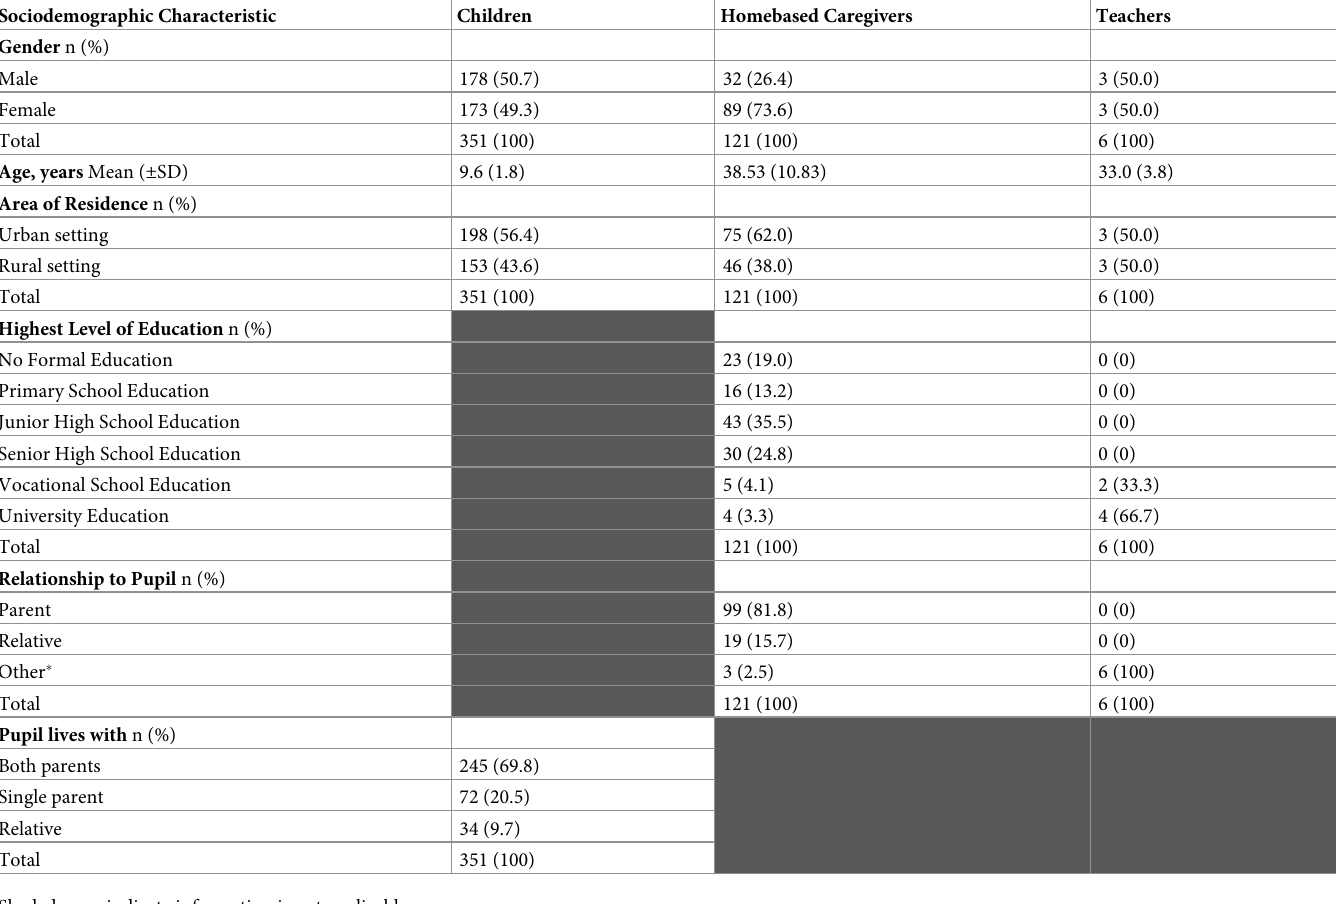
Table 1. Sociodemographic characteristics of study participants. Sociodemographic